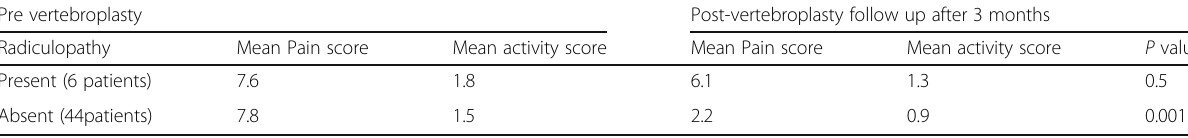
Table 8 Comparison between patients with or without associated radiculopathy Pre vertebroplasty Post-vertebroplasty follow up after 3 months